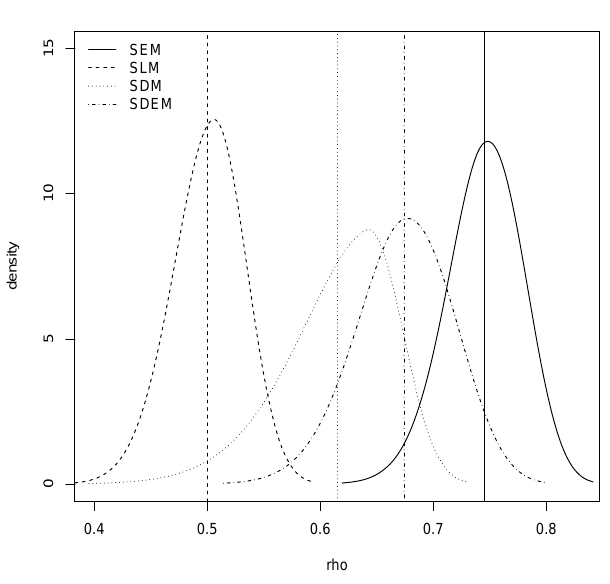
Figure 1. Posterior marginal of the spatial autocorrelation parameters with posterior means (vertical lines), Boston housing data.